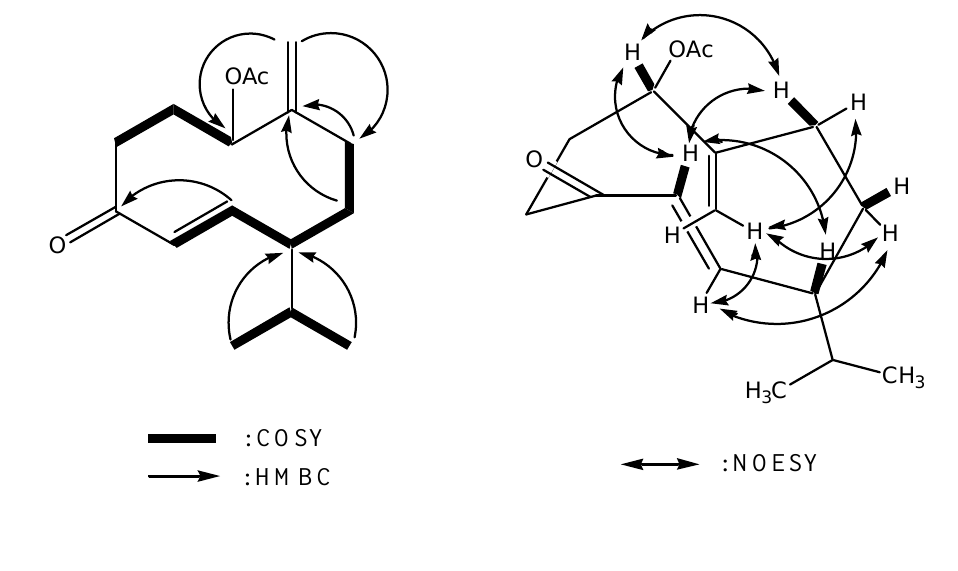
Figure 2. Selected 2D NMR correlations for 1